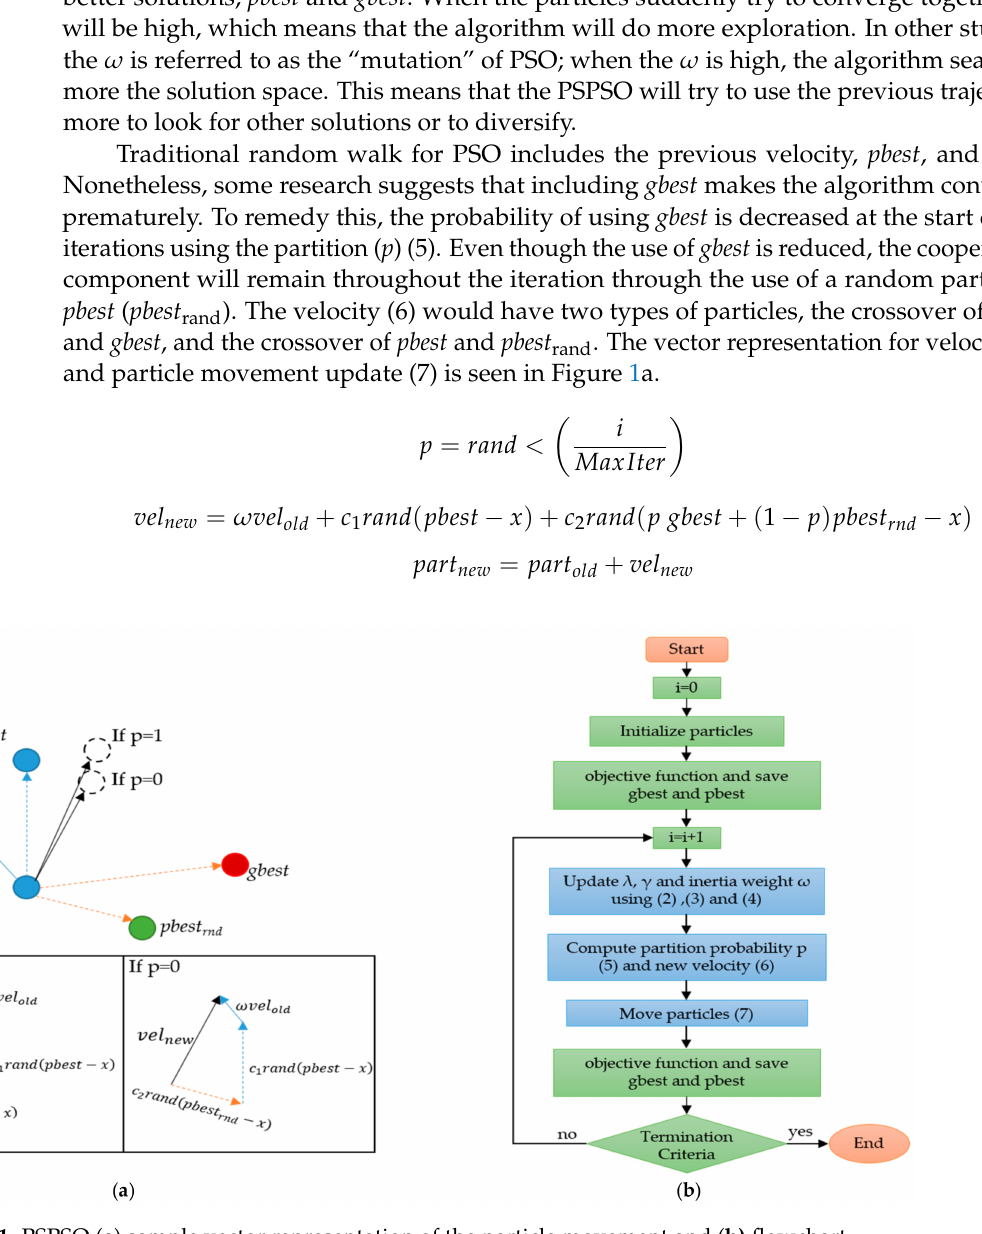
Figure 1. PSPSO ( a ) sample vector representation of the particle movement and ( b)